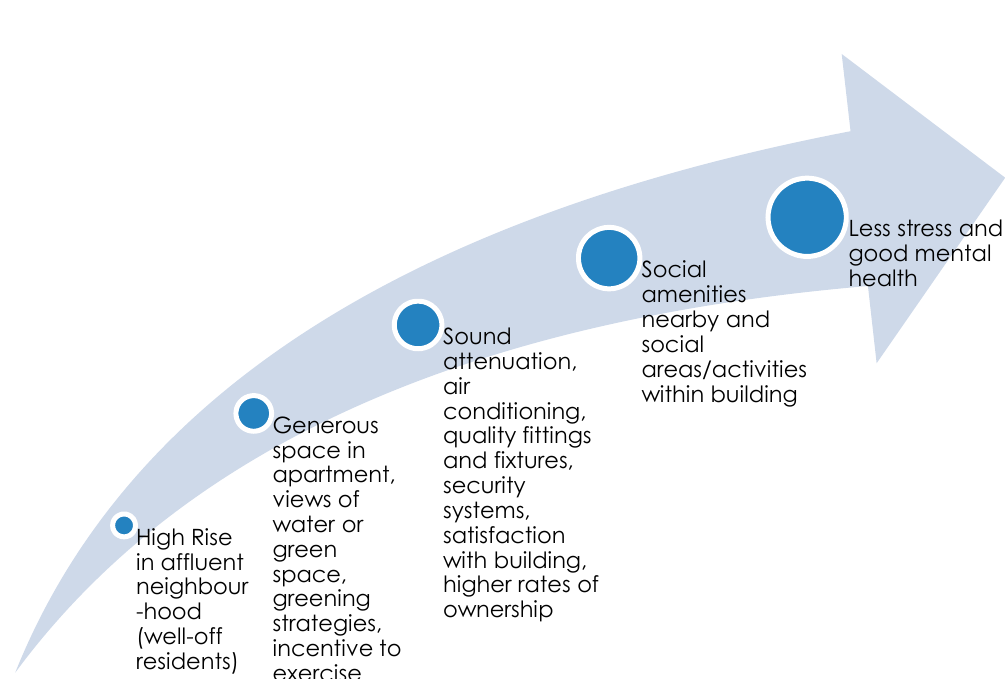
Figure 2. A possible causal sequence of high-rise apartments in affluent areas where good environmental health, satisfaction of living space, access to green space and social amenities that lead to higher ownership, may lead to less stress and good mental health.